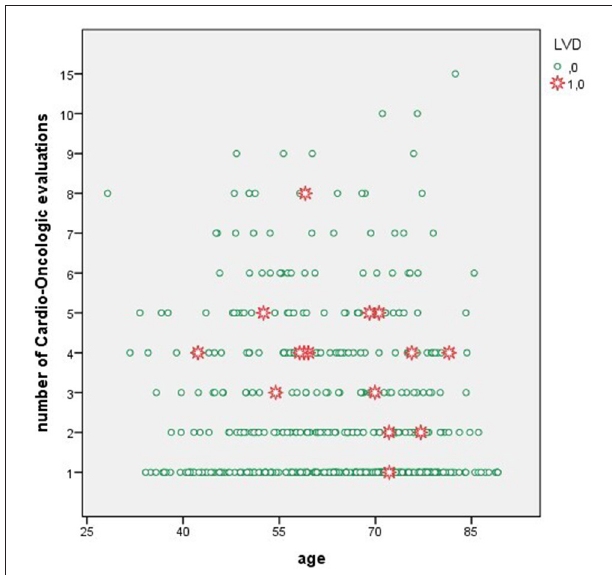
FIGURE 2 | Distribution of LVD events according to number of Cardio-Oncologic evaluations.